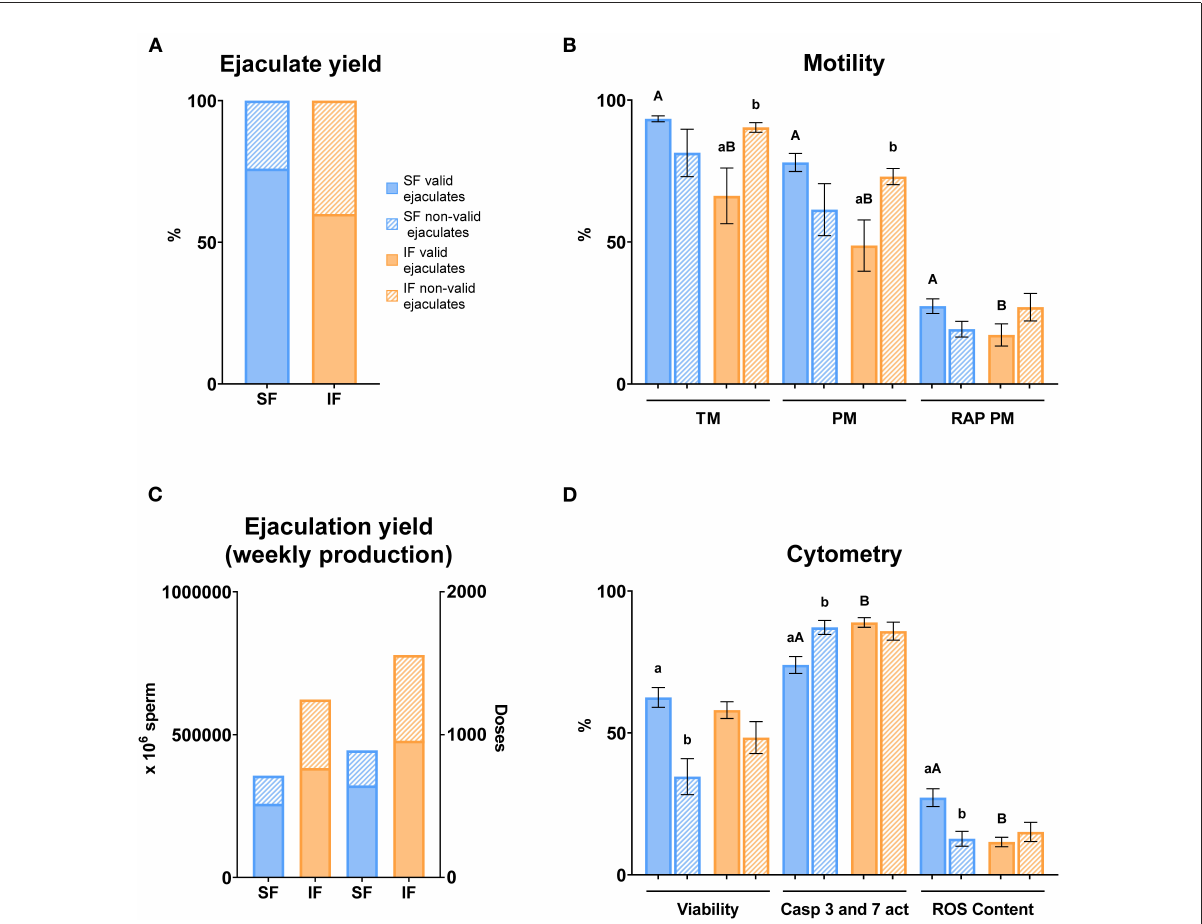
FIGURE11 Semen yield and sperm quality in valid and non-valid ejaculates. Criteria of valid ejaculate: ejaculate volume > 0.5ml, mass motility > 3, sperm concentration > 3,000 × 10 6 sperm/ml. Non-valid ejaculates: some of the criteria previously described below the minimum value. (A) Ejaculate yield: % of valid and non-valid ejaculates in two semen collection frequencies (SF, standard semen collection frequency; IF, intensive semen collection frequency corresponding with IFF; Friday); (B) Motility: sperm samples of SF (blue columns) and IF (orange columns); TM, total motility (%); PM, progressive motility (%); RAP PM, rapid progressive motility (%); (C) Ejaculation yield (weekly production): number of sperm and doses produced weekly in two semen collection frequencies (SF and IF); (D) Cytometry: sperm samples of SF (blue columns) and IF (orange columns); Viability, Zombie Violet TM (%); Caspases 3 and 7 activity, CellEvent TM Caspase-3/7 Green (%); ROS content, CellROX TM Deep Red (%). The same 25 males were analyzed in each experimental group. Different lowercase superscripts letters (a,b) indicate differences ( P ≤ 0.05) for